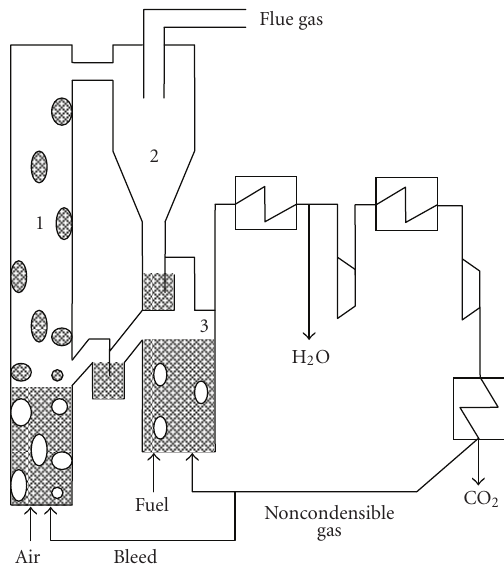
Figure 3: Layout of chemical-looping combustion process, with two interconnected fluidized beds. (1) air reactor, (2) cyclone, (3) fuel